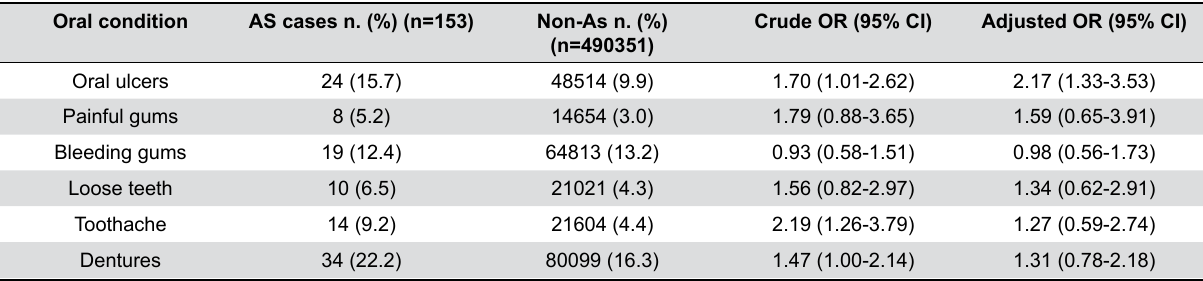
Table 6- Prevalence of self-reported oral conditions in the clinically diagnosed AS cases and control groups, excluding participants who reported having dentures